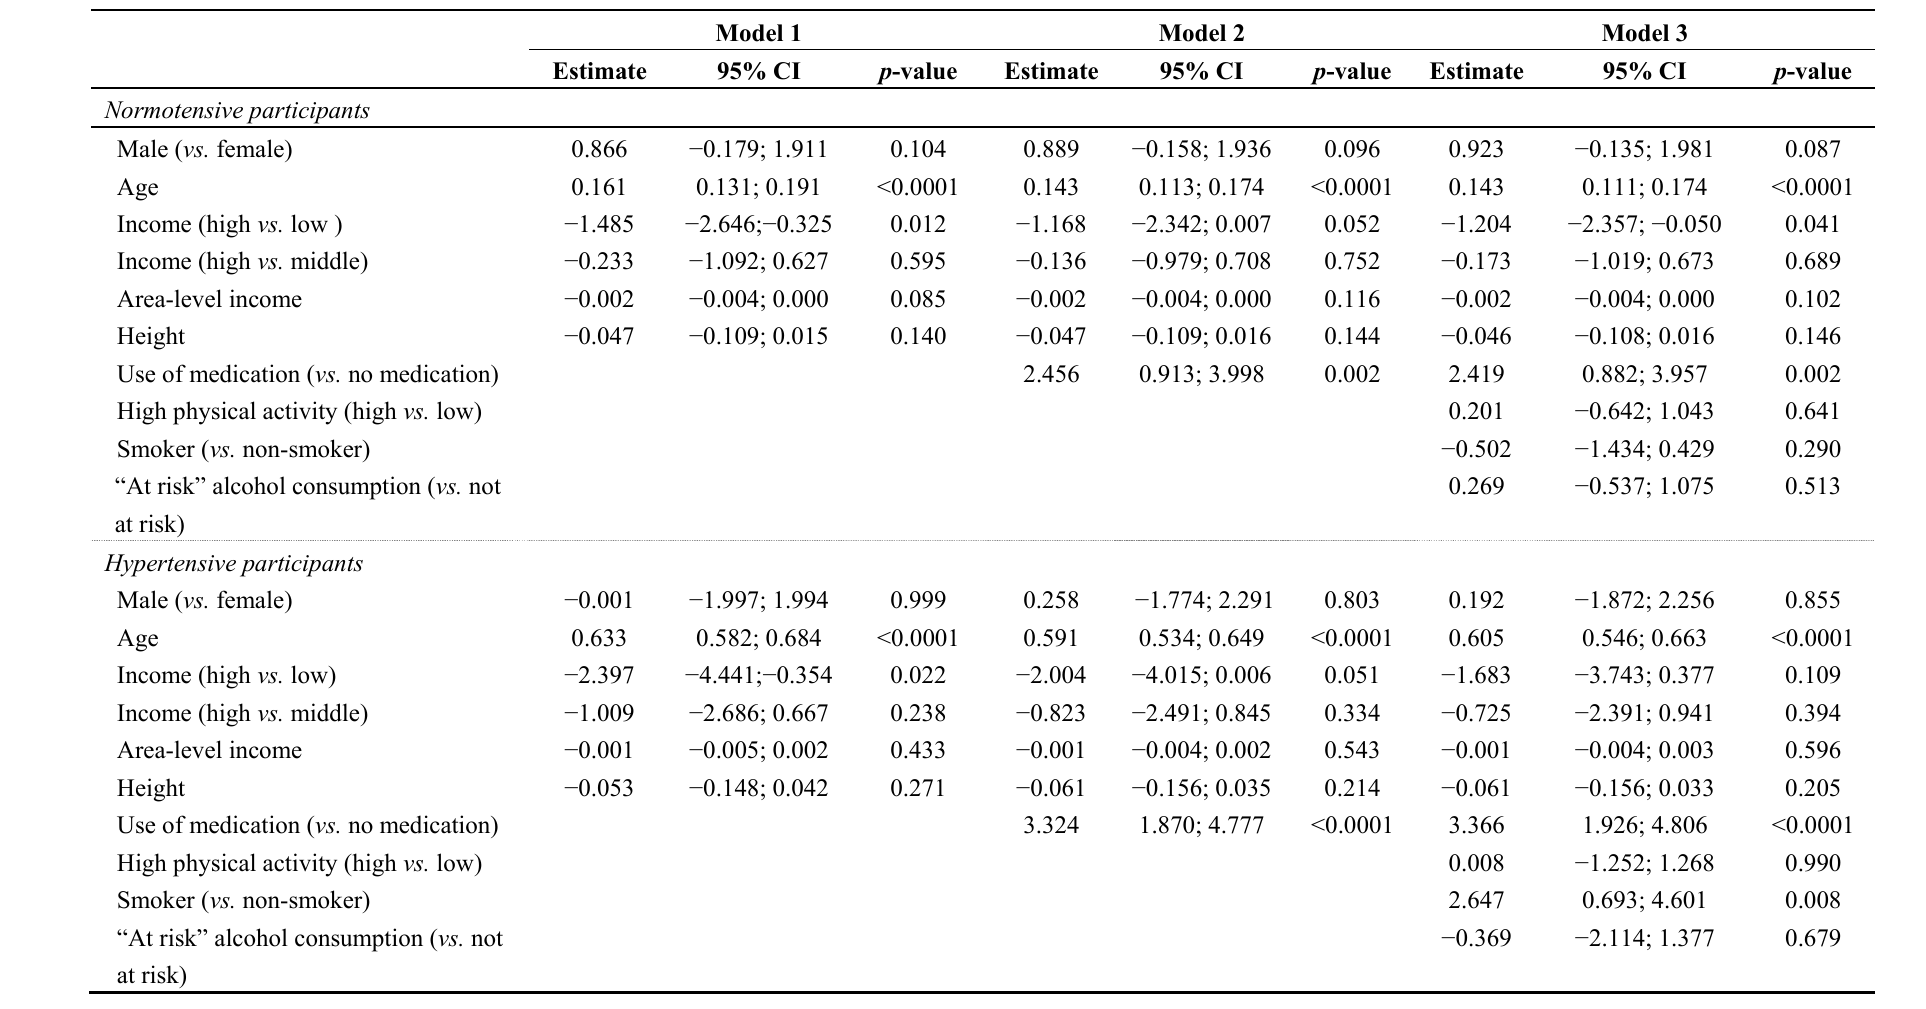
Table 3. Results of models testing the associations between pulse pressure and household income, according to hypertensive